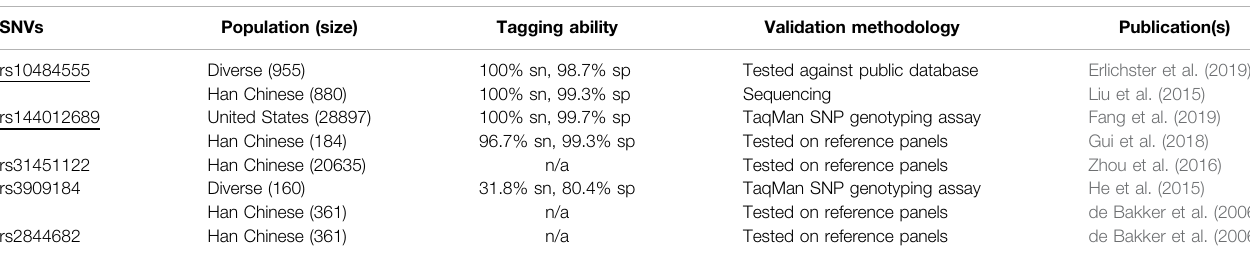
TABLE 2 | Prior data on HLA-B*15:02 potential tag SNVs.